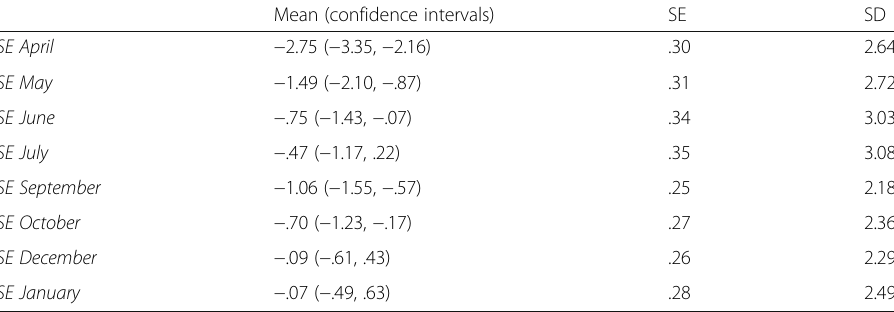
Table 2 Descriptive Statistics for self-efficacy